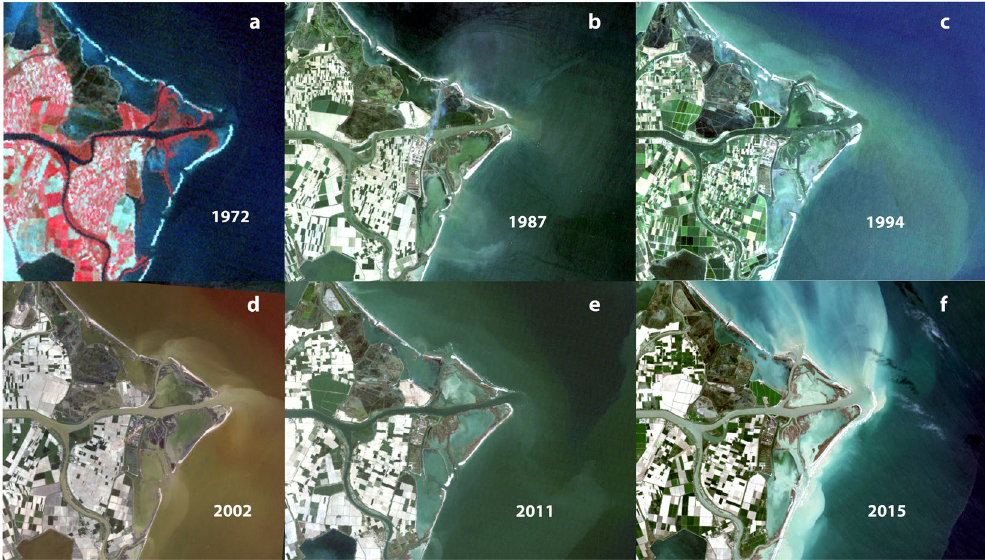
Figure 2. Landsat satellite images: ( a ) L1MSS-12 August 1972 (60 m); ( b ) L5TM 8 May 1987 (30 m); ( c ) L5TM 14 July 1994 (30 m); ( d ) L7ETM 23 April 2002 (30 m); ( e ) L5TM 17 April 1991 (30 m); ( f ) L8OLI 3 April